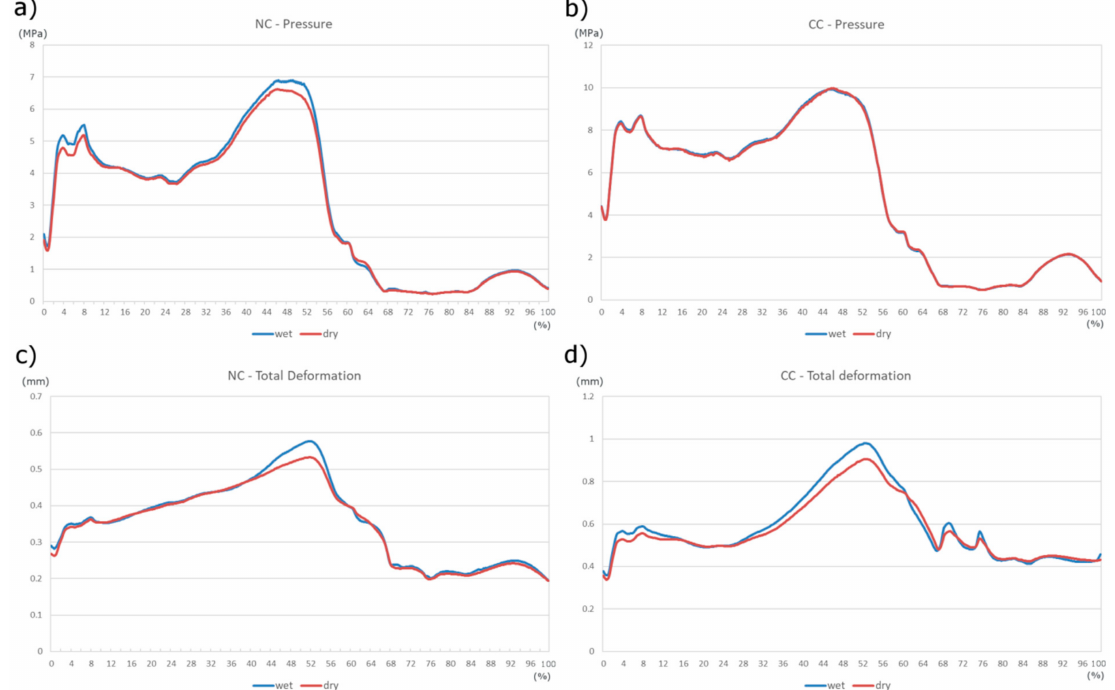
Figure 6. Comparison of result in the NC ( a , c ) and CC ( b , d ) cases, between the dry and wet